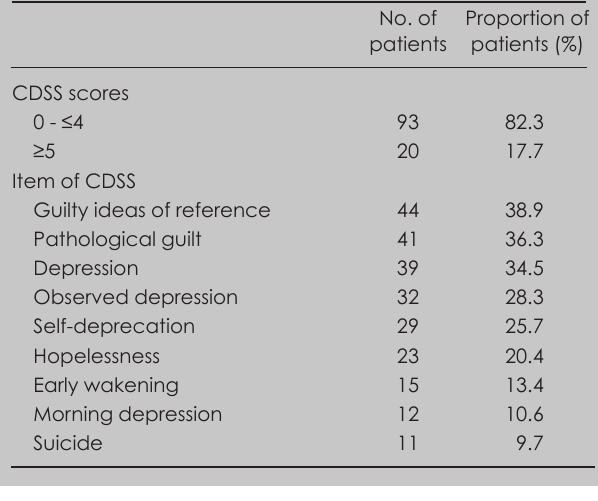
Table I. Demographic characteristics of patients with Kraepelinian schizophrenia ( N =113) Characteristic Total